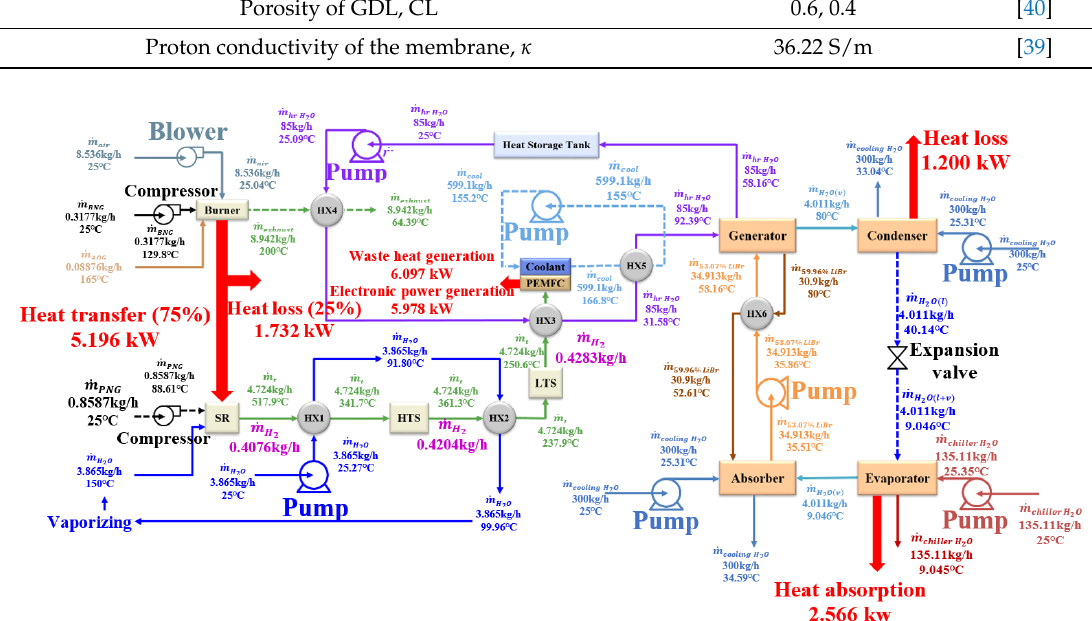
Figure 7. Configuration of mass and heat-flow diagram for trigeneration system at 0.2 A/cm 2.